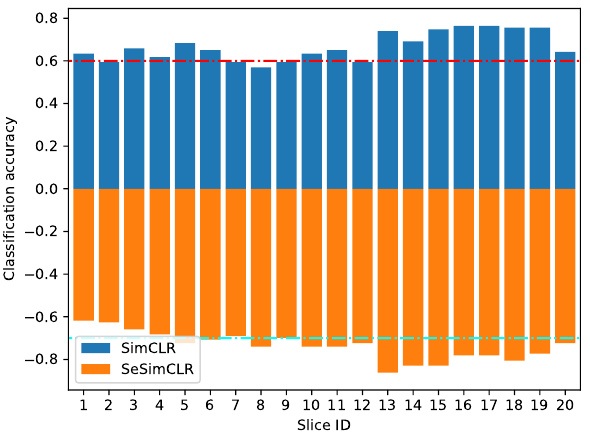
Figure 6. Classification accuracy on per image ID. The slice ID indicates the image id number of the 20 slices for each student. The negative probabilities were set to plot